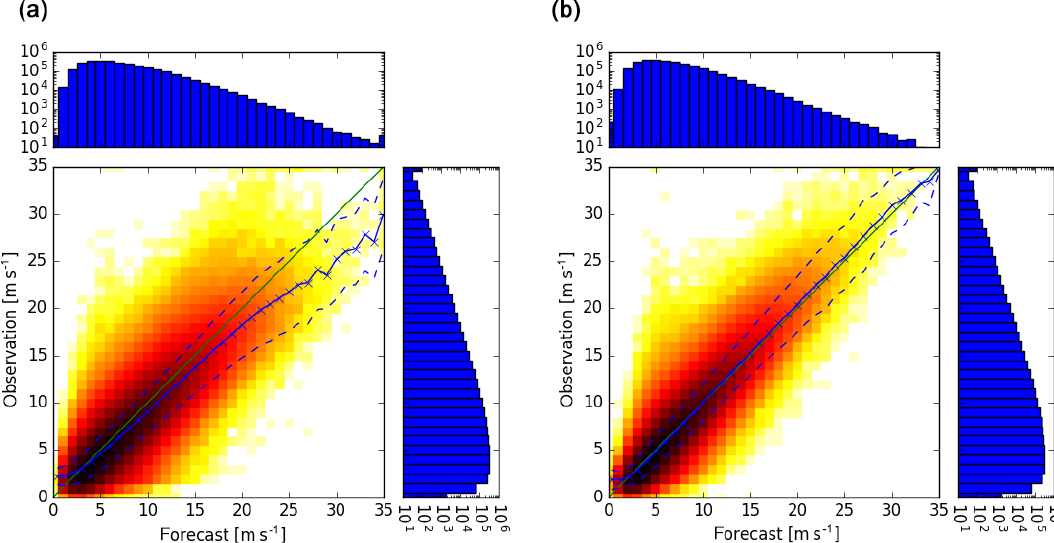
Figure 7. As Fig. 6 but for 8h forecasts of COSMO-DE-EPS (a) and 6h forecasts of Ensemble-MOS (b) .